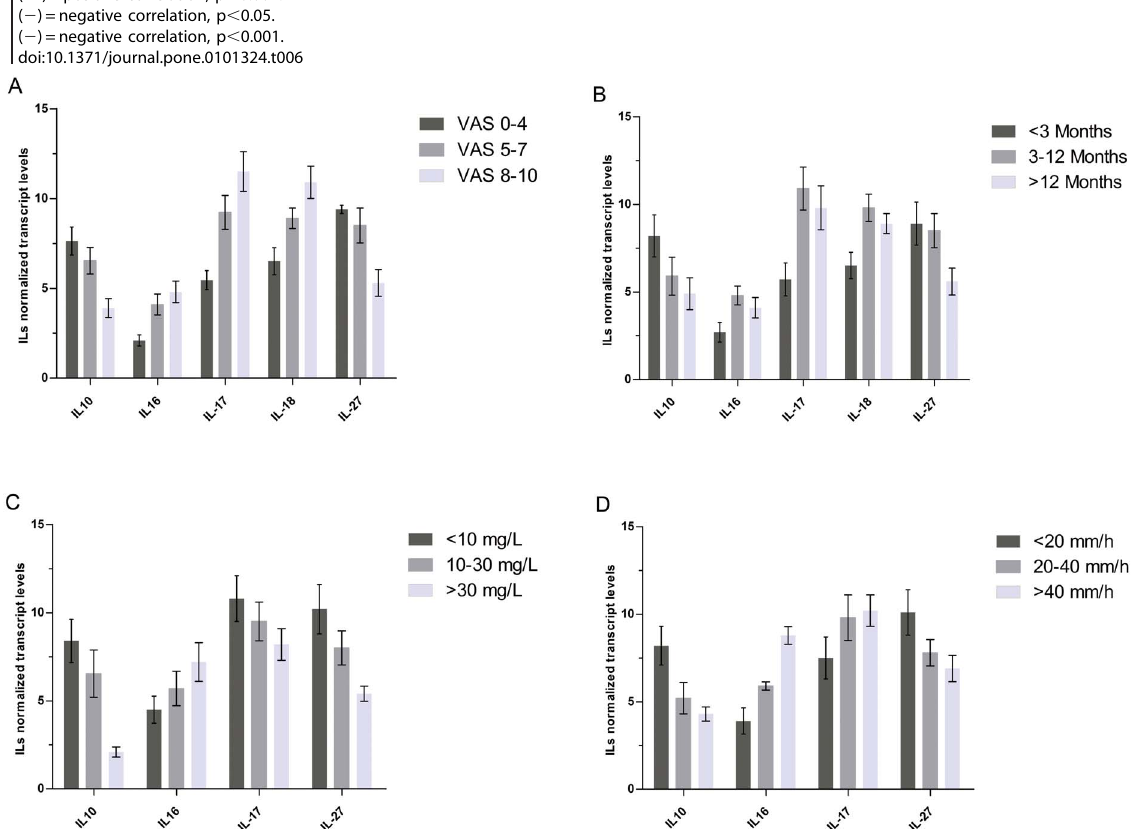
Figure 4. Normalized transcript levels of interleukins (ILs) in the TB group with respect to pain intensity (A), symptom duration (B), C-reactive protein (CRP) levels (C) and the erythrocyte sedimentation rate (ESR) (D). A illustrates that patients experiencing intense pain (visual analog scale [VAS] score=8–10) exhibited higher IL-16, IL-17, and IL-18 mRNA levels than patients experiencing mild pain (VAS score=0–4). Meanwhile, patients experiencing mild pain exhibited higher IL-10 and IL-27 mRNA levels than patients experiencing intense pain (P , 0.05). B reveals that patients who experienced pain for 3–12 months exhibited significantly higher IL-16, IL-17, and IL-18 mRNA levels than those who experienced pain for , 3 months. Conversely, patients who experienced pain for , 3 months exhibited significantly higher IL-10 and IL-27 mRNA levels than those who experienced pain for 3–12 months (P , 0.05). C indicates that the mRNA levels of IL-16 and IL-17 were significantly higher in patients with high CRP levels ( . 30 mg/L), whereas IL-10 and IL-27 levels were significantly higher in patients with low CRP levels ( , 10 mg/L) (P , 0.005). D illustrates that the mRNA levels of IL-16 and IL-17 were significantly higher in patients with high ESRs ( . 40 mm/h). Conversely, IL-10 and IL-27 levels were significantly higher in patients with low ESRs ( , 20 mm/h) (P ,